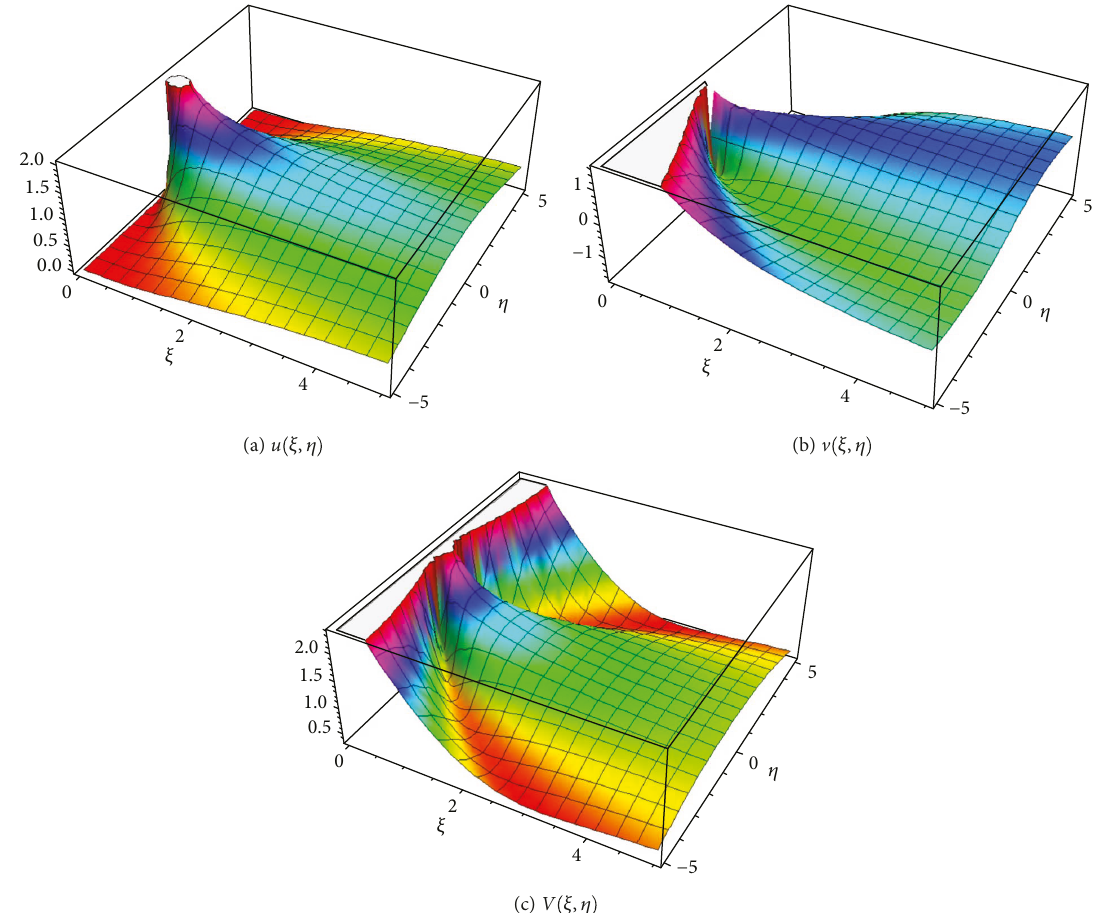
Figure 1: Space dependences of the normalized fractal velocity fi eld components (a, b) and its norm (c), as given by (20) for μ = 1